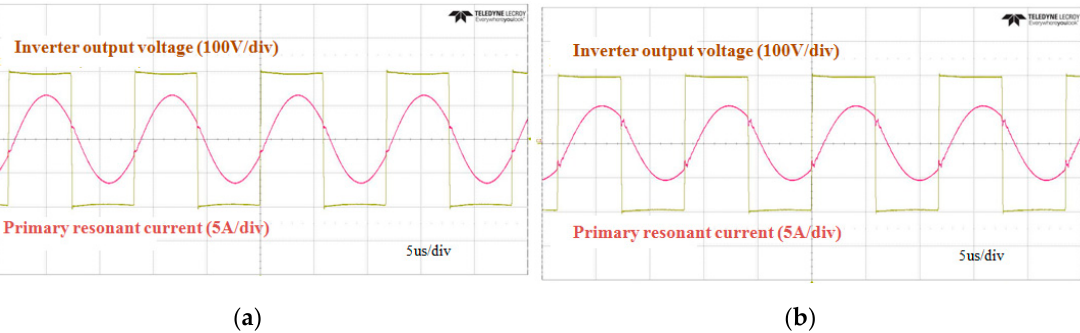
Figure 24. Zero voltage switching (ZVS) waveform with ( a ) 14 Ω load resistance; ( b ) 180 Ω load resistance.